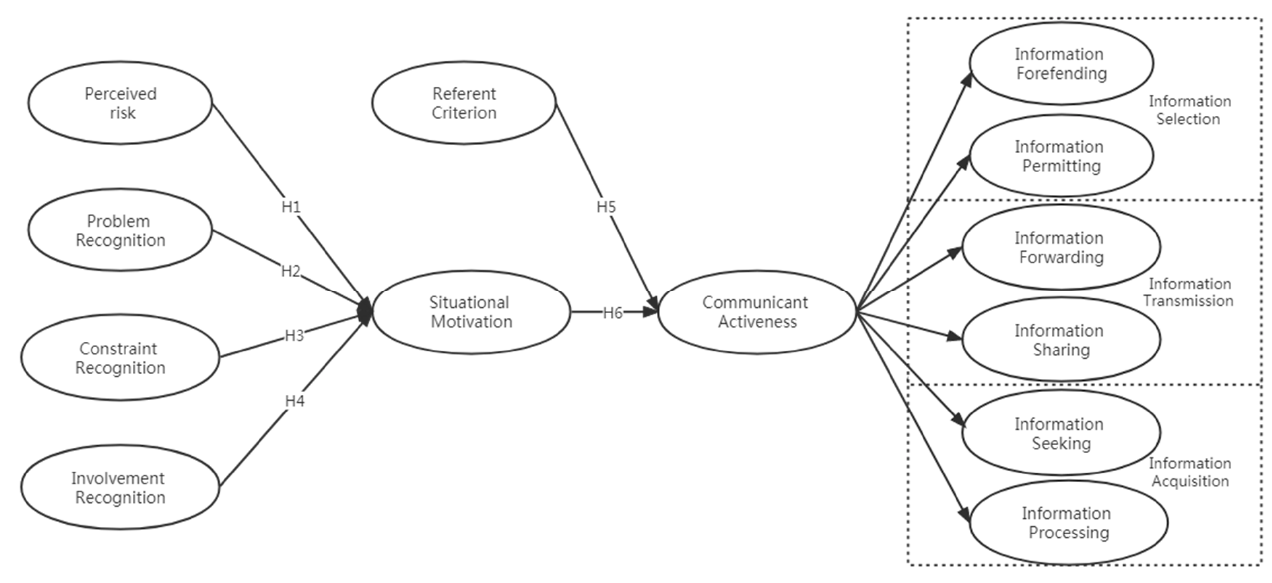
Figure 1. Research model diagram.